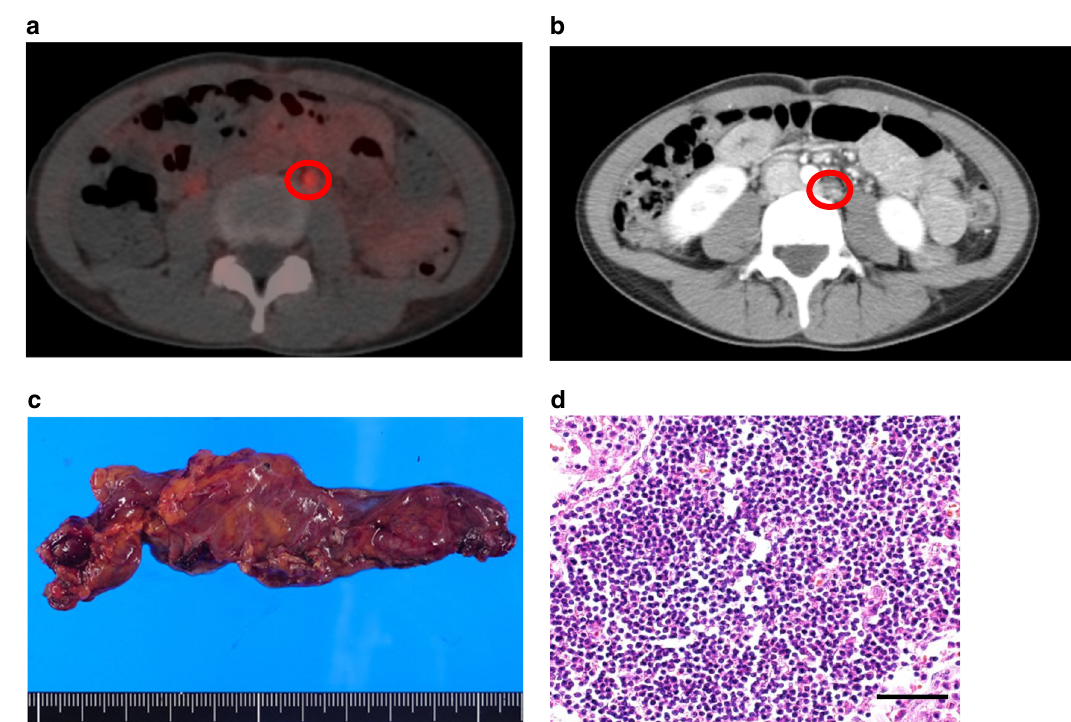
Fig. 1 A case of cervical cancer in which 18F-FDG-PET/CT produced false-positive results. a , b Preoperative fi ndings. a A transverse 18F-FDG-PET/CT image demonstrating increased 18F-FDG uptake in a left paraaortic lymph node (PALN) (circle). b A transverse CT image showing an enlarged left PALN (circle). c , d Postoperative fi ndings. c Macroscopic appearance of the resected left PALN that had increased 18F-FDG uptake on preoperative 18F-FDG- PET/CT. d Representative pathological fi ndings from the resected 38 lymph nodes (hematoxylin and eosin). No tumor cells were noted. Scale bars, 50 mm. The image contains no malignant cells. Scale bar, 50 μ m.